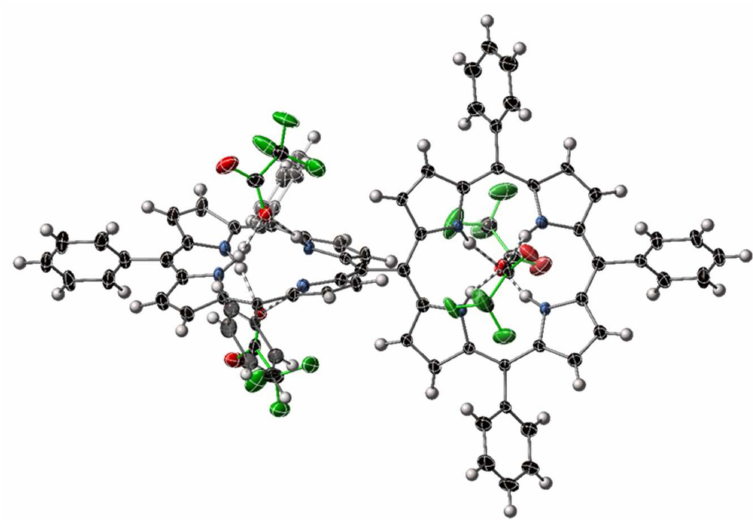
Figure 7. View of an individual molecule of [H 8 24 ][CF 3 CO 2 ] 4 within [H 8 24 ][CF 3 CO 2 ] 4 · 14H 2 O. Solvents are omitted from this representation; thermal ellipsoids are shown at the 50% level. Trifluoroacetate anions are highlighted with green